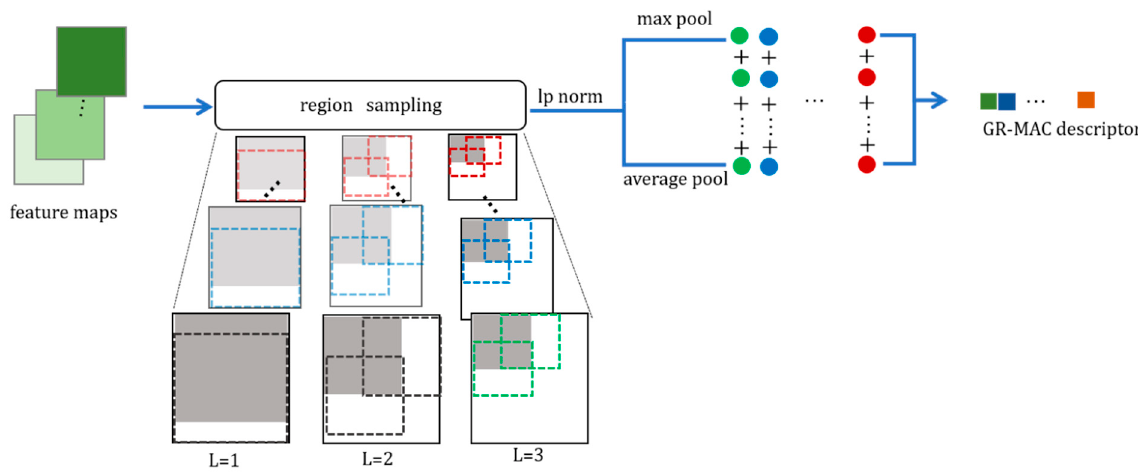
Figure 4. Generalized R-MAC. The squares with different green depths represent the feature maps of each channel obtained by an image through different convolution kernels, and the regions are divided. A series of green circles in the figure indicate that each region of a channel-wise feature map passes through the feature values calculated by the 𝑙𝑝 norm. In the same way, the blue circle, the green circle, etc. are a series of feature values obtained in each region of other channels. The GR-MAC descriptor means the feature vector produced by the generalized R-MAC, as shown in Equation (13).